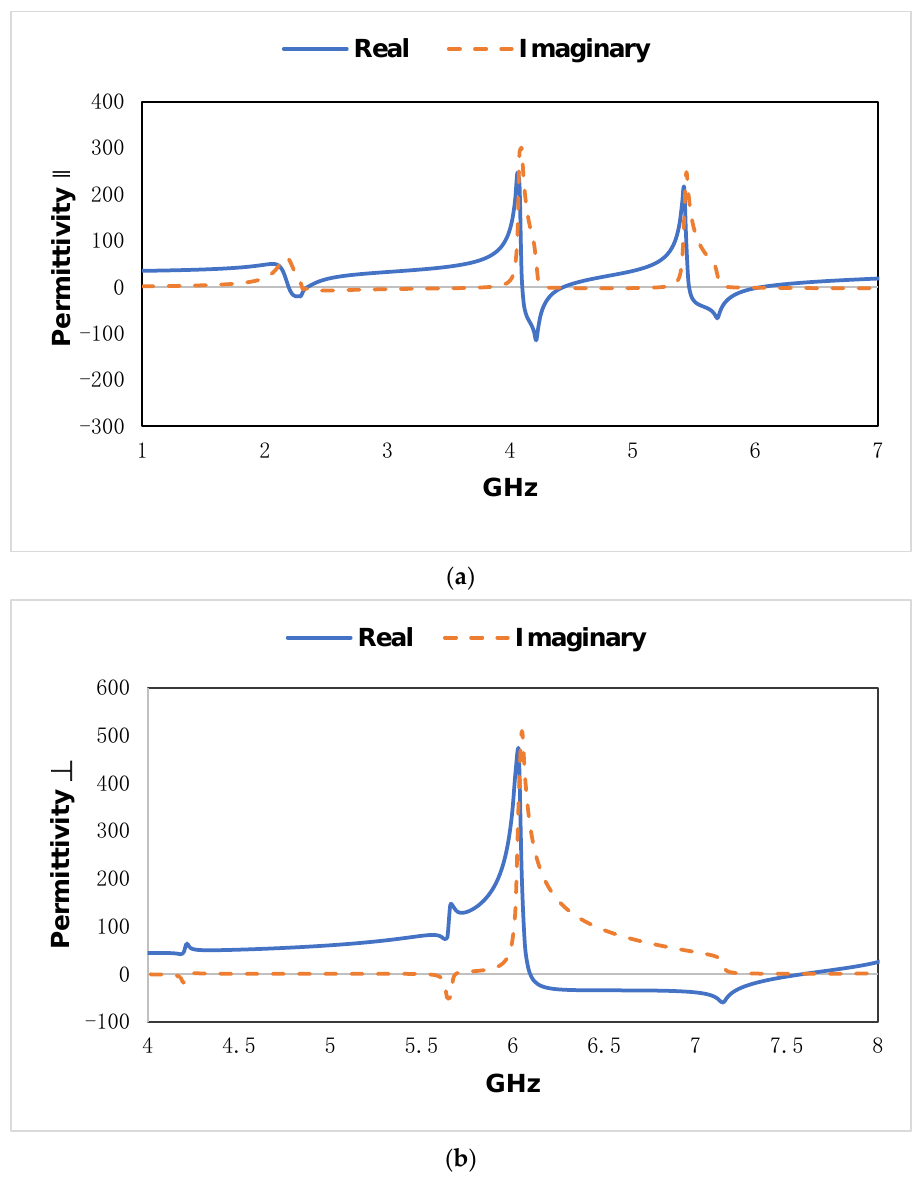
Figure 9. Parallel component ( a ) and perpendicular component ( b ) of the effective permittivity. For the first resonant frequency in Figure 10a, the electric field is distributed at a high intensity on the horizontal side of the outer metallic strip, in the gap between the metallic strips. For the second resonant frequency, the electric field is distributed at the edge of the outer metallic ring, in the gap between the middle metallic strip and the inner bent metallic strip. At the cutting of the bent metallic layer and the junction of the two bent metallic slots, the electric field accumulated at a high intensity to produce the electric resonance on the metamaterial unit cell. For the third resonant frequency, the confinement of the electric field is exhibited diagonally around the inner bent metallic strip.